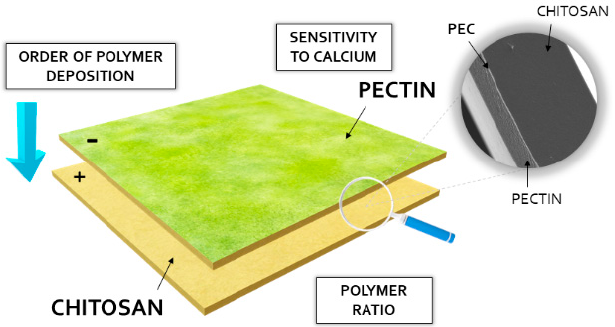
Figure 10. The scheme of the film preparation technique with an indication of the factors being op ‐ timized.